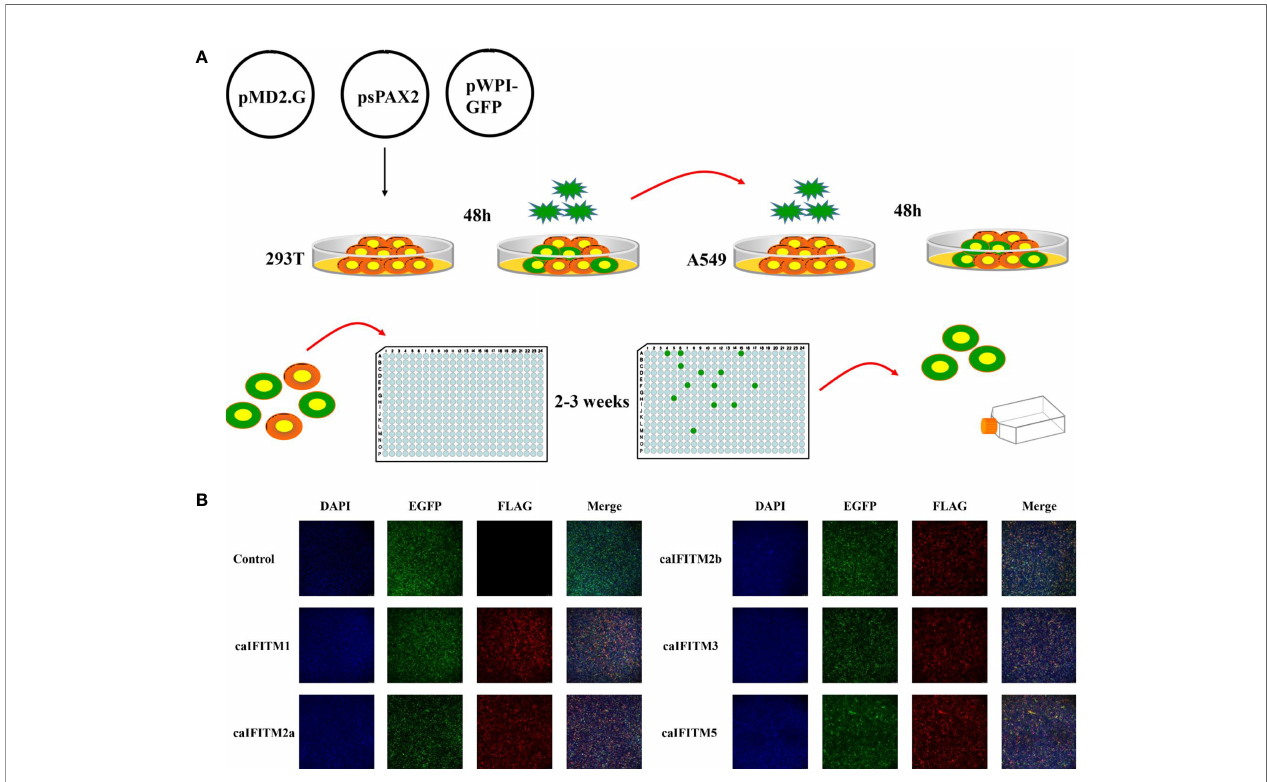
FIGURE 6 | Establishment of A549 cell lines stably expressing caIFITMs. (A) Experimental process of generating and screening A549 cell lines stably expressing caIFITMs. HEK 293T cells were transfected with lentivirus packaging system. After 48 h, lentivirus in the cell culture supernatant was collected and was used for infecting A549 cells. After 48 h, A549 cells were trypsinized and seeded in 96-well plates by the limiting dilution assay and cultured for 2 – 3 weeks. Cell clones expressing fl uorescence expression were selected by a fl uorescence microscope. (B) Detection of caIFITM expression using the indirect immuno fl uorescence method. A549 cells stably expressing Flag-tagged caIFITMs were seeded on glass-bottomed coverslips. After 24 h, the cells were stained with an anti-FLAG antibody (red) and the nucleus was stained with DAPI (blue). Finally, the cells were analyzed by a fl uorescence